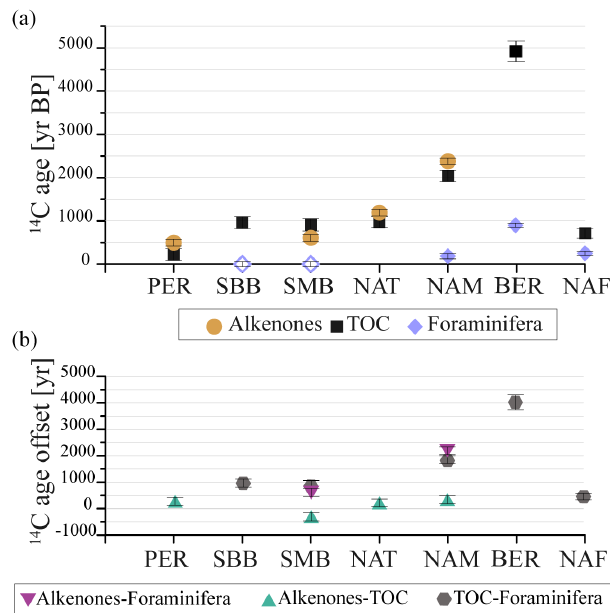
Figure 3. Radiocarbon ages of alkenones (this study), TOC and planktic foraminifera (Ausín et al., 2021) from bulk sediment sam- ples (a) and age discrepancies among them (b) . Open diamonds in- dicate foraminifera that incorporate bomb 14 C.